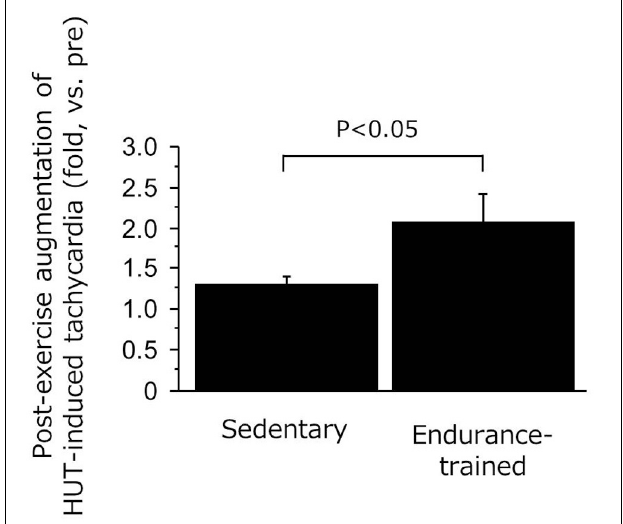
FIGURE 4 | Ratio of HUT-induced tachycardia responses (post/pre) in the sedentary and endurance-trained men. HUT-induced tachycardia response was calculated as the heart rate during HUT minus heart rate in supine position. Data are mean ± s.e.m.